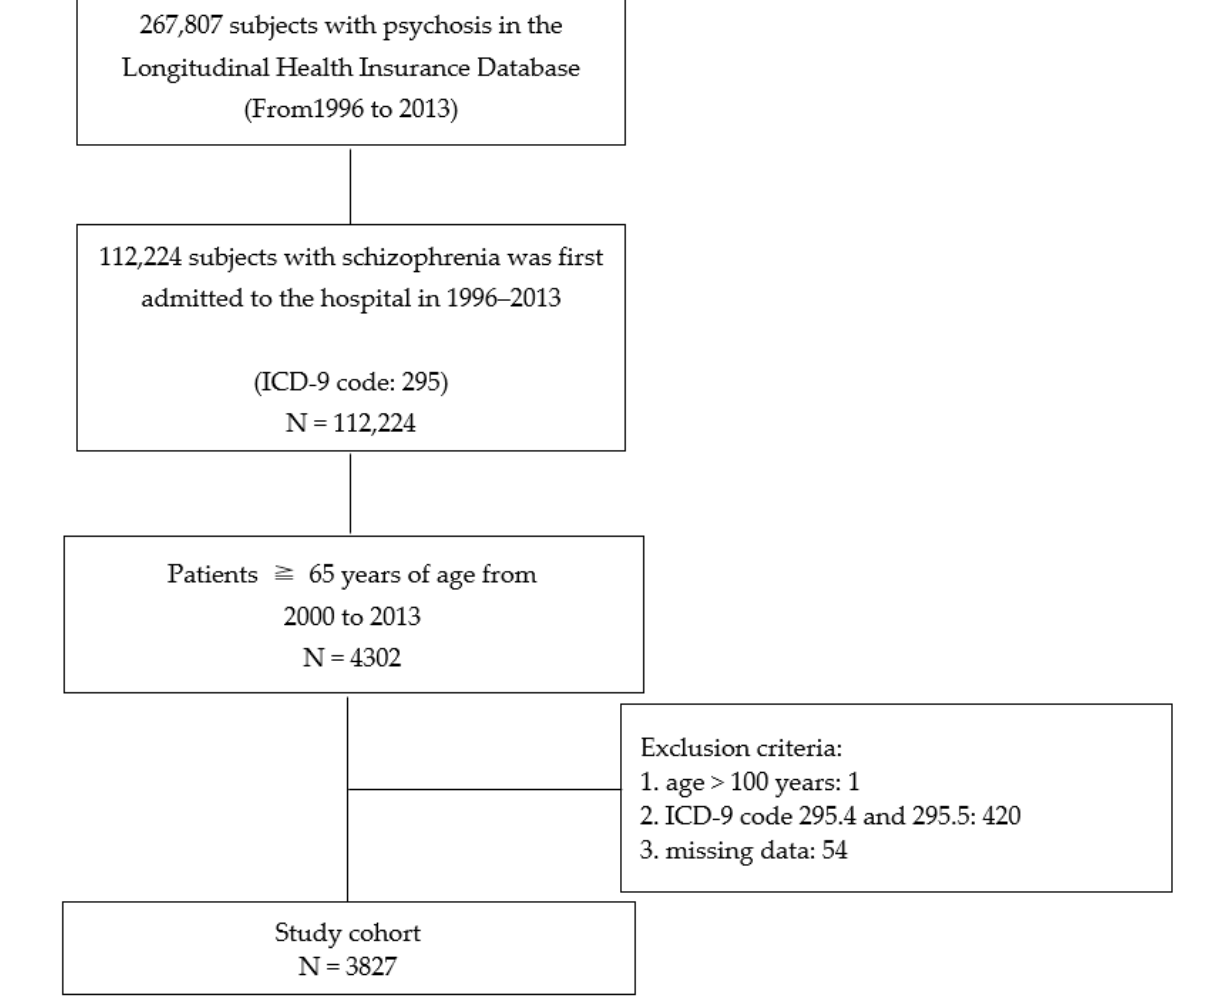
Figure 1. Flowchart of identification and enrolment of the study subjects.